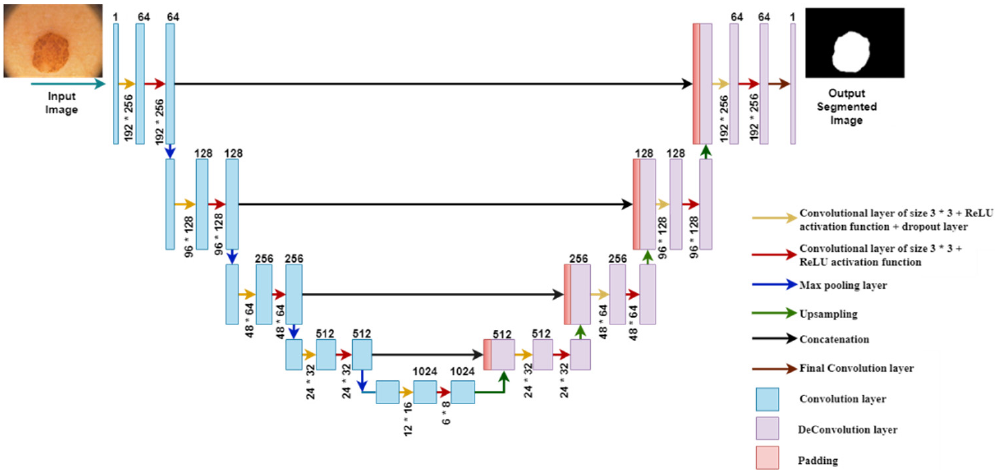
Figure 4. Modified U-Net Architecture.